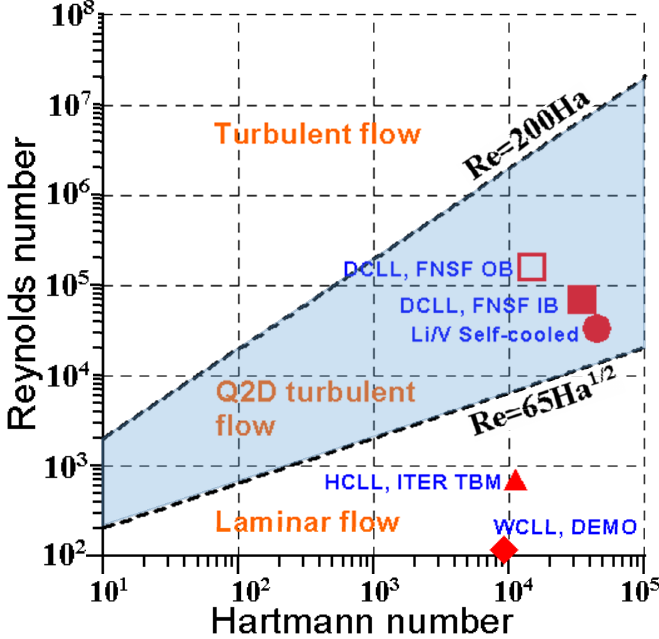
Figure 9. Ha - Re diagram for MHD flow in a non-conducting rectangular duct.